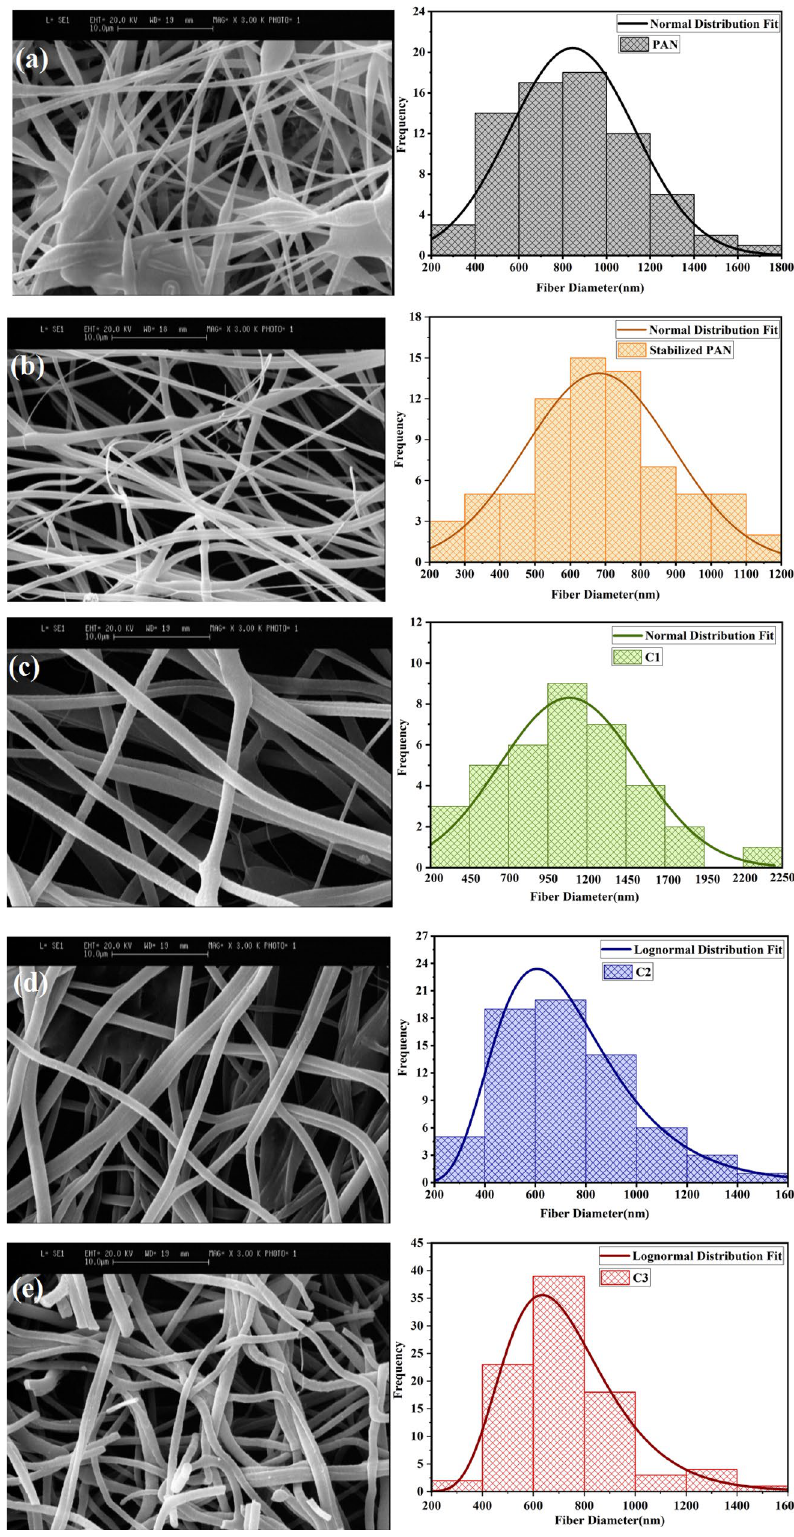
Figure 2. SEM micrographs and diameter size distribution of fibers, ( a ) PAN, ( b ) stabilized at 300 °C, ( c ) C1, ( d ) C2, and ( e )